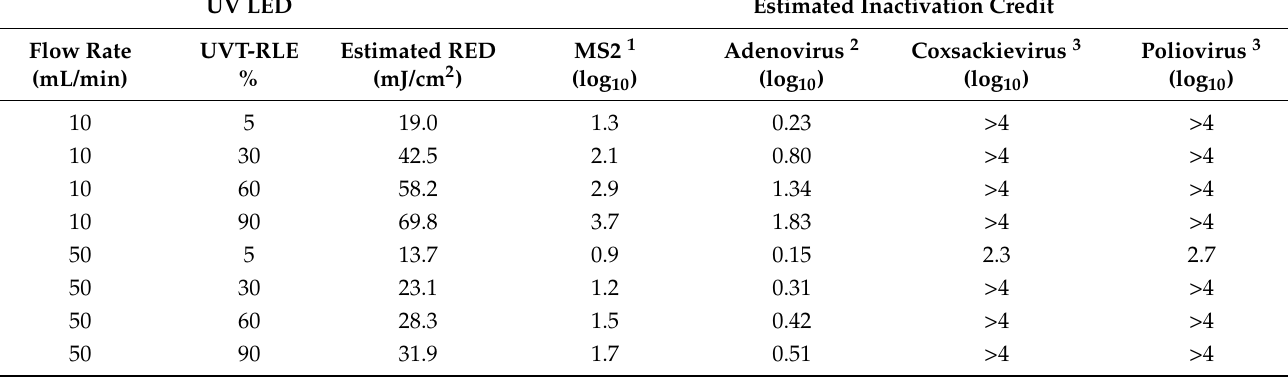
Table 4. Disinfection performance for the flow-through UV LED reactor estimated from Equations (2) and (3) for wastewater and septic tank effluent. RED is the reduction equivalent dose estimated from the combined variable model for a given flow rate and UVT. RLE = relative lamp equivalent.